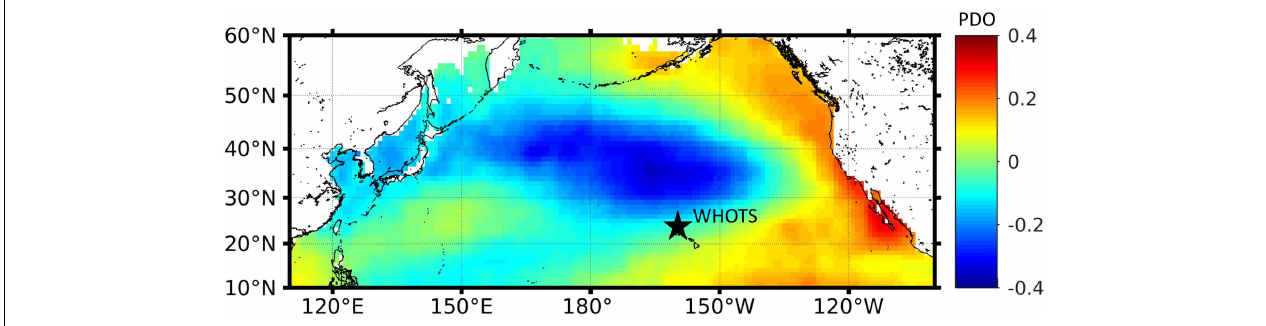
FIGURE 1 | The geolocation of the study site WHOTS (annotated in black star), and the general climate mode of the North Pacific in terms of PDO based on the HadISST data set (Rayner et al., 2003) for the period 1870–2019.